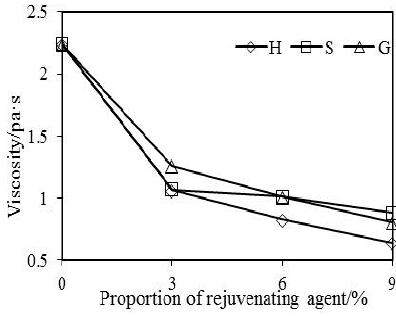
Figure 4. Relationship between penetration and viscosity.